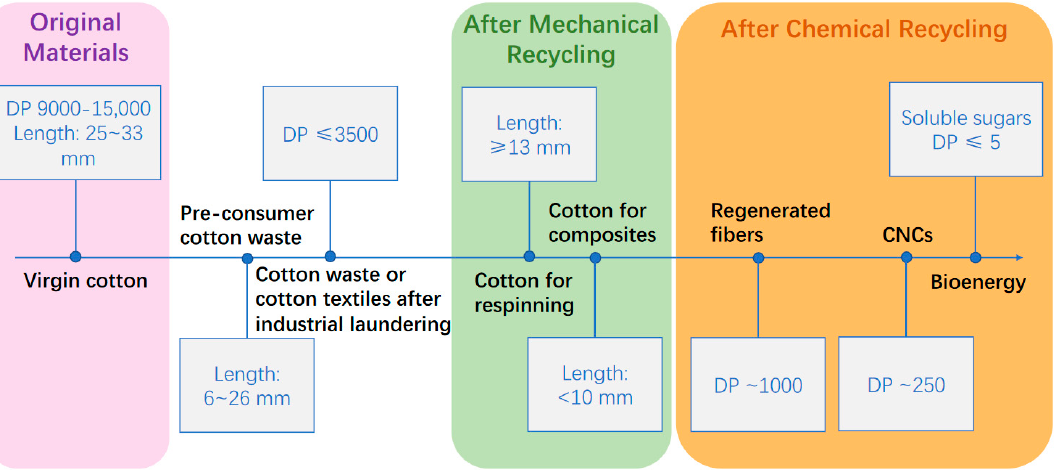
Figure 4. Schematic diagram showing changes in cotton microscale properties after different stages of use and recycling. Values are compiled from [58,64–73].